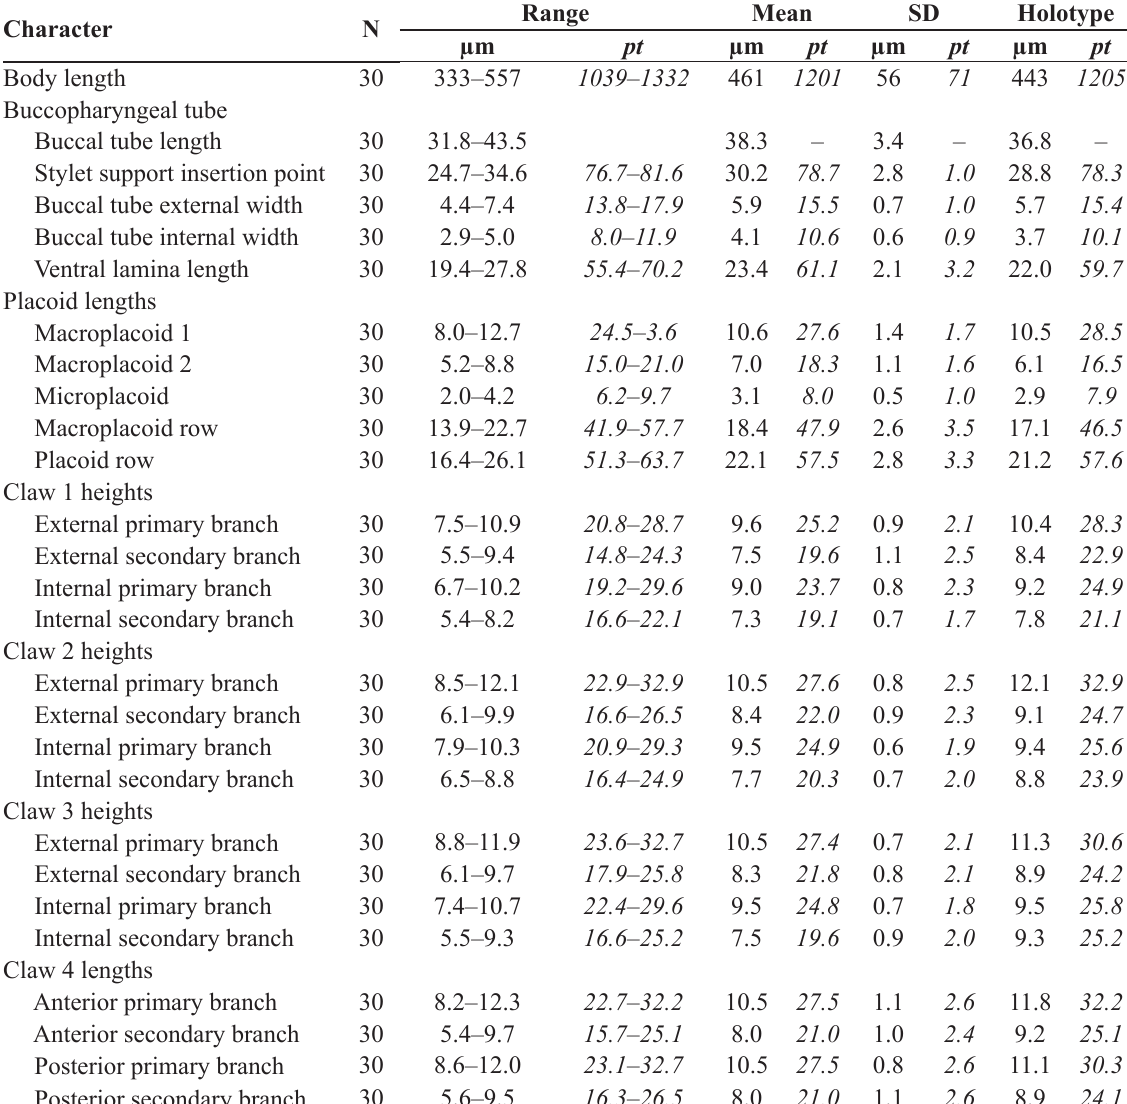
Table 2. Measurements (in μm) and pt values of selected morphological structures of the holotype and paratypes of Macrobiotus noongaris sp. nov. mounted in Hoyer’s medium (N = number of specimens/ structures measured; Range = the smallest and the largest structure among all measured specimens; SD = standard